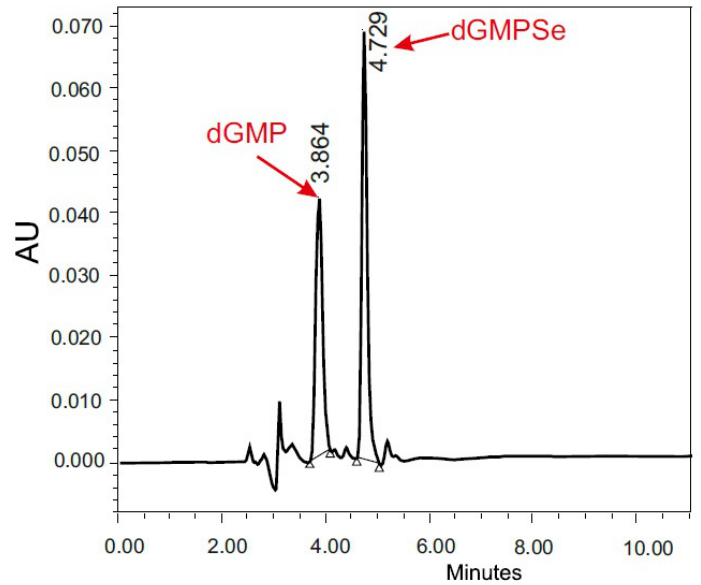
Figure 2. A RP-HPLC profile of the reaction mixture of dGMPSe with HINT1. The retention time (Rt) of the substrate is 4.729 min (dGMPSe) and of the product is 3.864 min (dGMP).